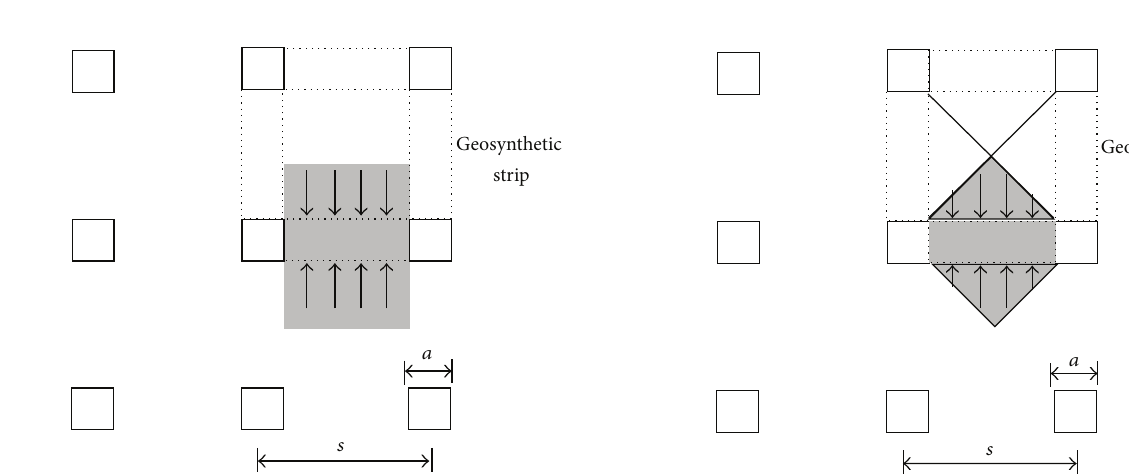
Figure 9: Calculation of the load to the geosynthetic strips in BS8006 (after [21]).